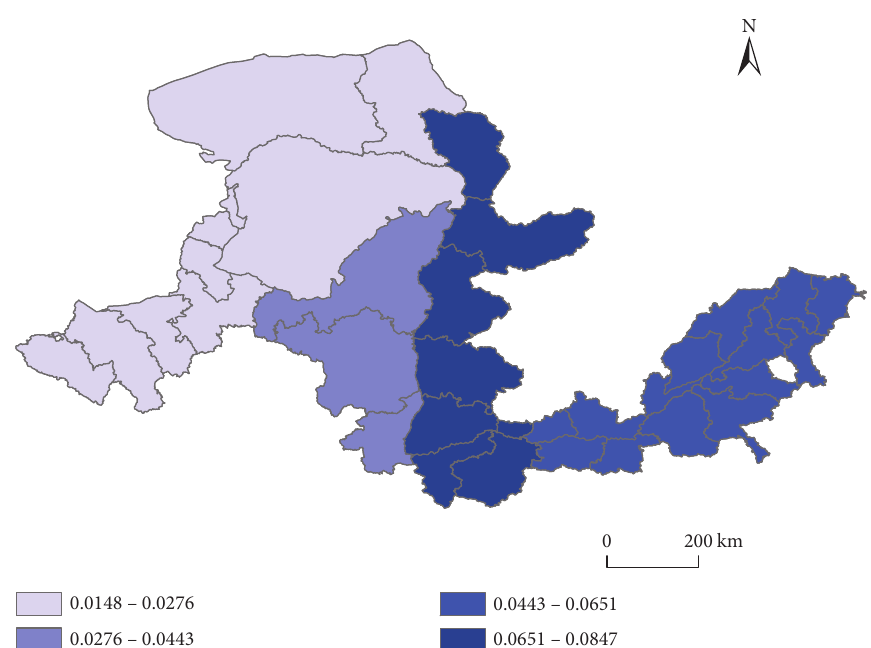
Figure 8: Spatial distribution of the regression coefficient of science and technology expenditures on